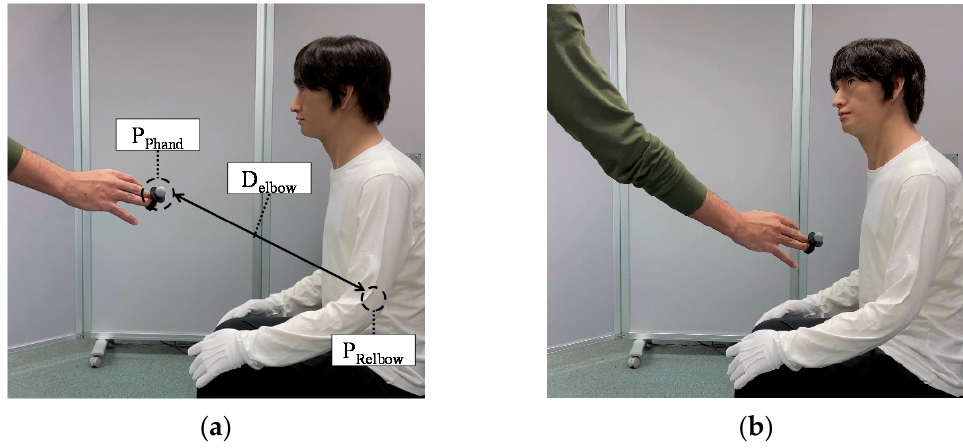
Figure 6. Reaction to potential touch to elbow implementing obtained model: ( a ) method used for